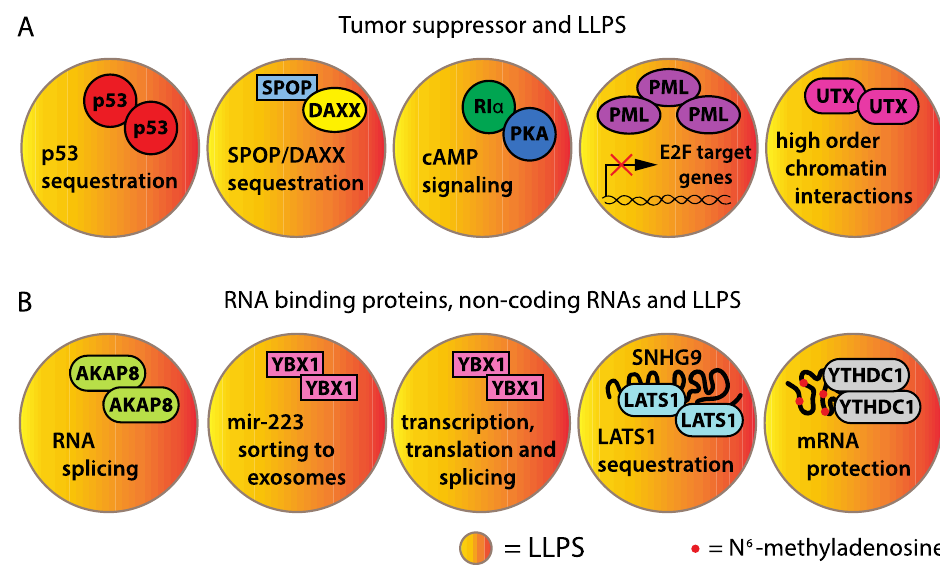
Figure 3. Tumor suppressor and RNA implication in LLPS. ( A ) Roles of tumor suppressors and/or their associated mutations in LLPS formation and downstream signaling in cancer. ( B ) Roles of RNA-binding proteins and non-coding RNAs in LLPS formation and downstream signaling in cancer.